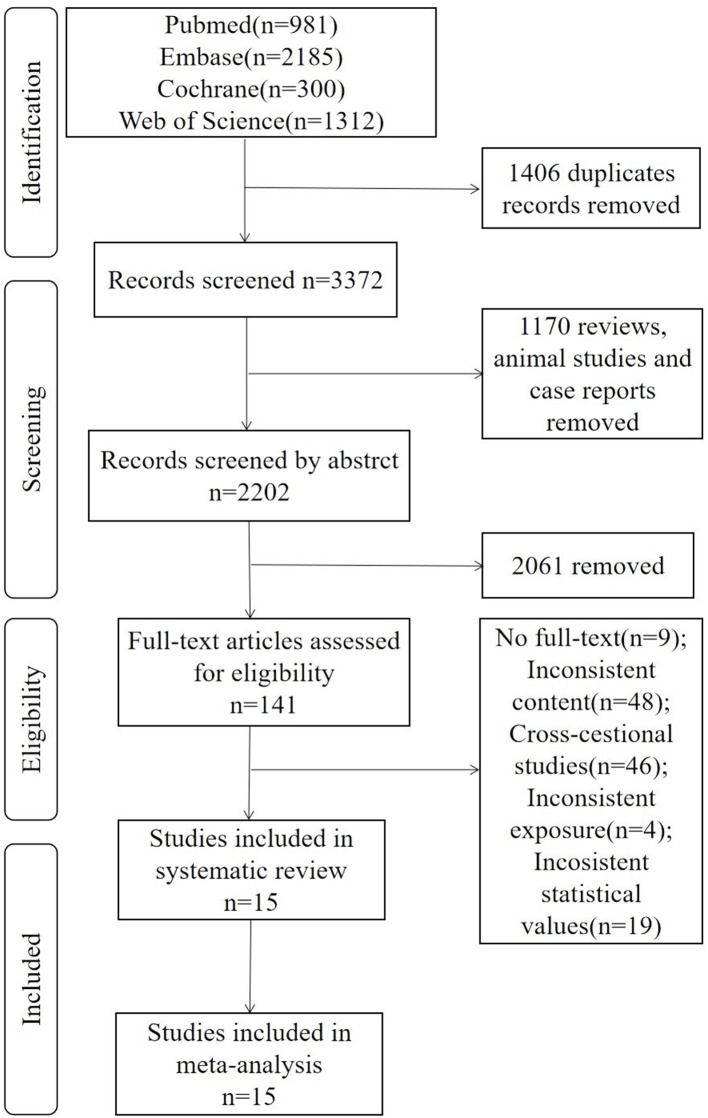
Flow diagram of the literature search.